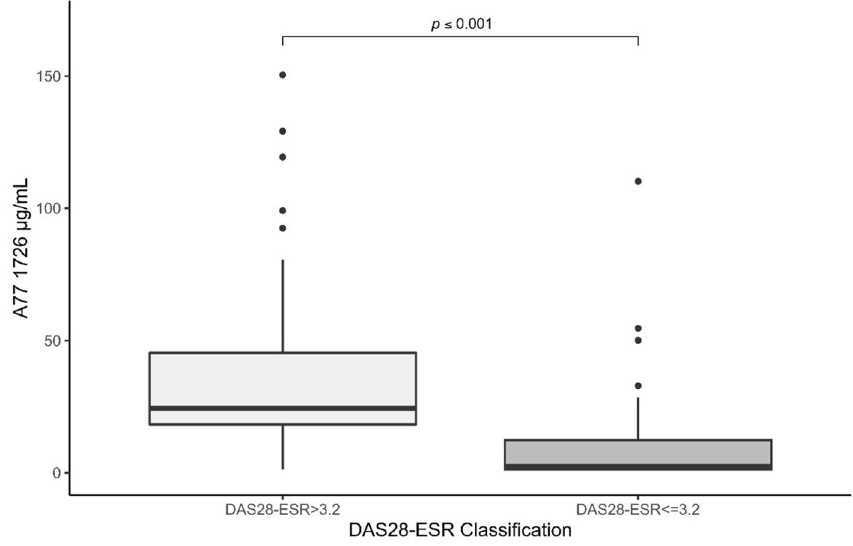
Figure 2. Box and whisker plots for A77 1726 serum concentrations in both groups, DAS28-ESR ≤ 3.2 and DAS28 > 3.2. Circles indicate outlying values.